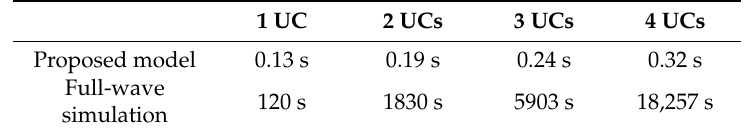
Table 2. Computation time for estimating CM and differential transmission characteristics of